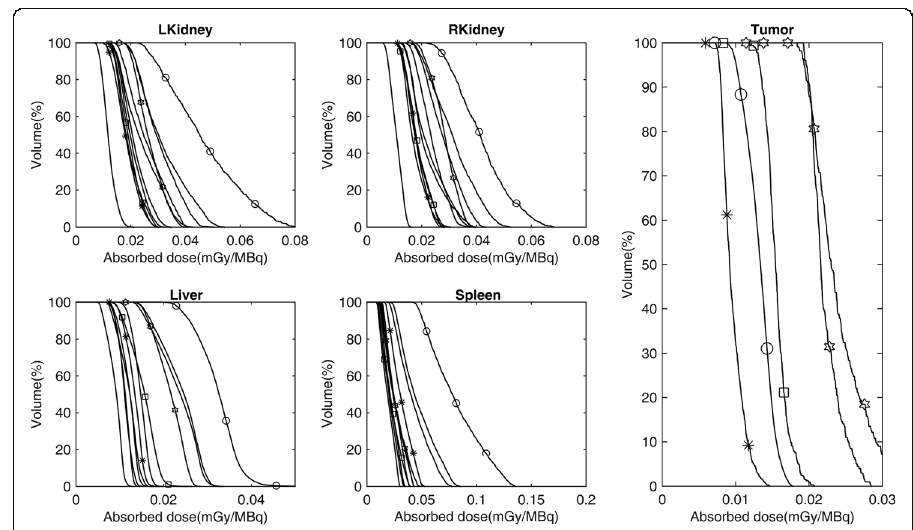
Fig. 8 Dose-volume histograms (DVHs) for normal organs and tumors. Each line represents a different patient; the lines with symbols represents the patients with pathologic